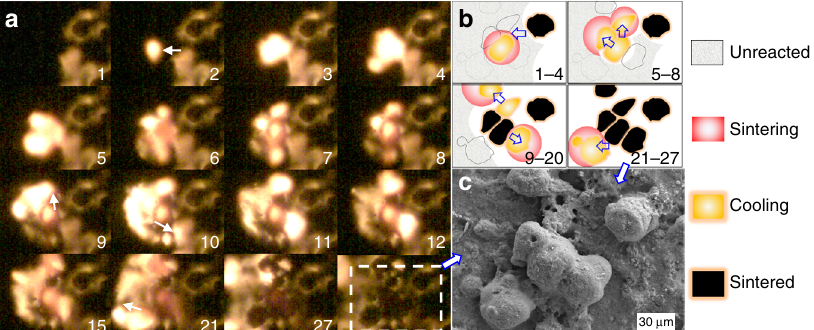
Fig. 4 High-speed microscopy images capturing the reactive sintering process in-operando. a Series of reactive sintering and ignition snapshots of a group of particles (labeled is frame sequence, 55.55 µ s per frame, scale bar: 100 µ m) and b its corresponding schematic cartoon. Note: The marked arrows are propagating direction. c The corresponding scanning electron microscopy (SEM) image of the sintered Al 2 O 3 particles coated with Cu nanoparticles, as evident by the energy-dispersive spectrometry (EDS) results in Fig. S5